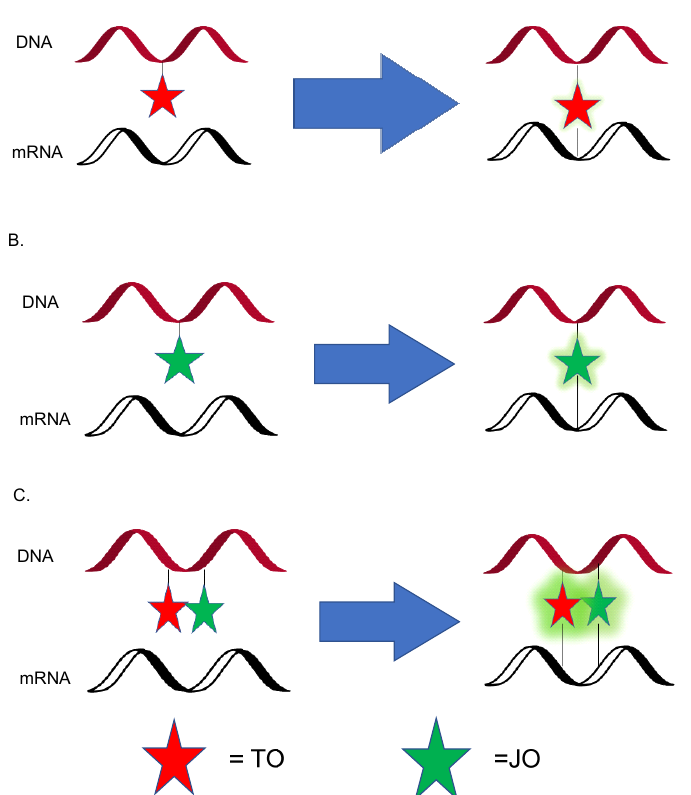
Figure 7. ( A ) TO labeled forced intercalation (FIT) probe. ( B ) JO labeled FIT probe. ( C ) TO–JO complex labeled FIT probe.